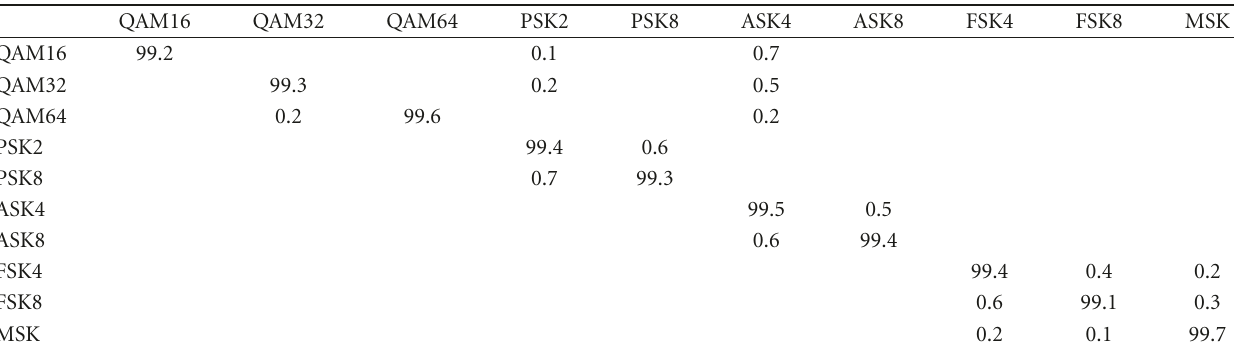
Table 2: Confusion matrix at SNR = 4d B.